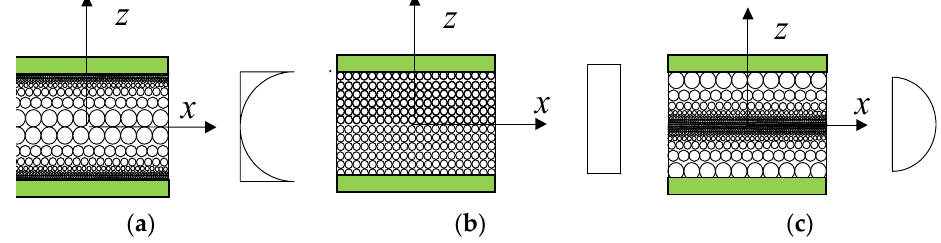
Figure 2. Porosity distribution patterns of the core layer: ( a ) Pattern X P ; ( b ) Pattern U P ; ( c ) Pattern O P .